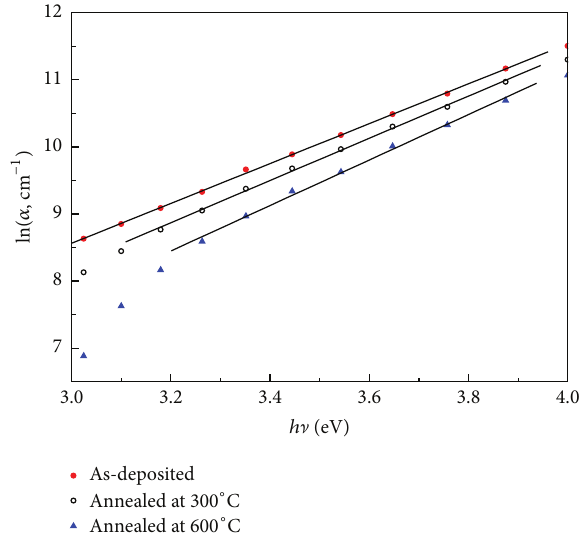
Figure 9: Urbach relation for as-deposited and annealed ITO thin